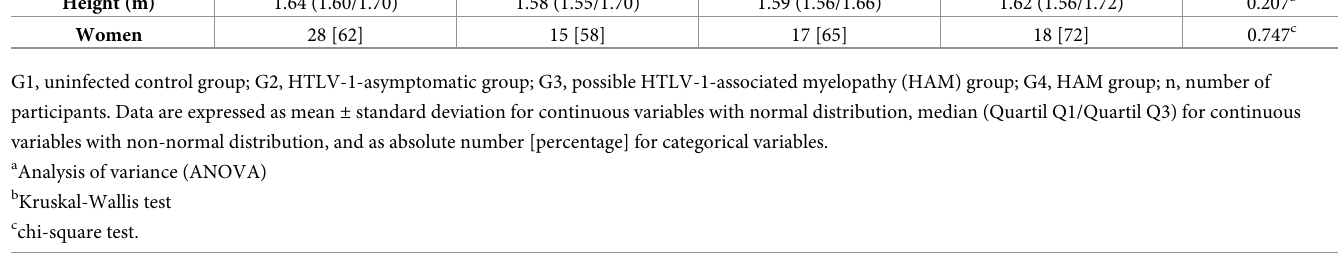
Table 1. General characteristics of human T-cell lymphotropic virus type 1 (HTLV-1)-infected and -uninfected groups (n = 122). Variables